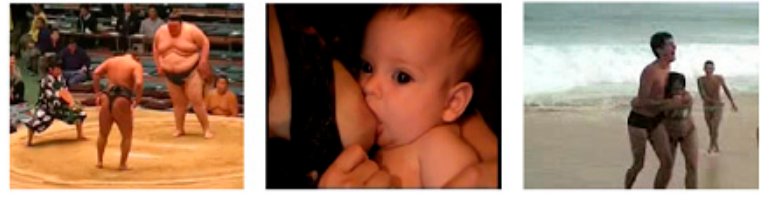
Figure 1. Sample images from dataset [21].